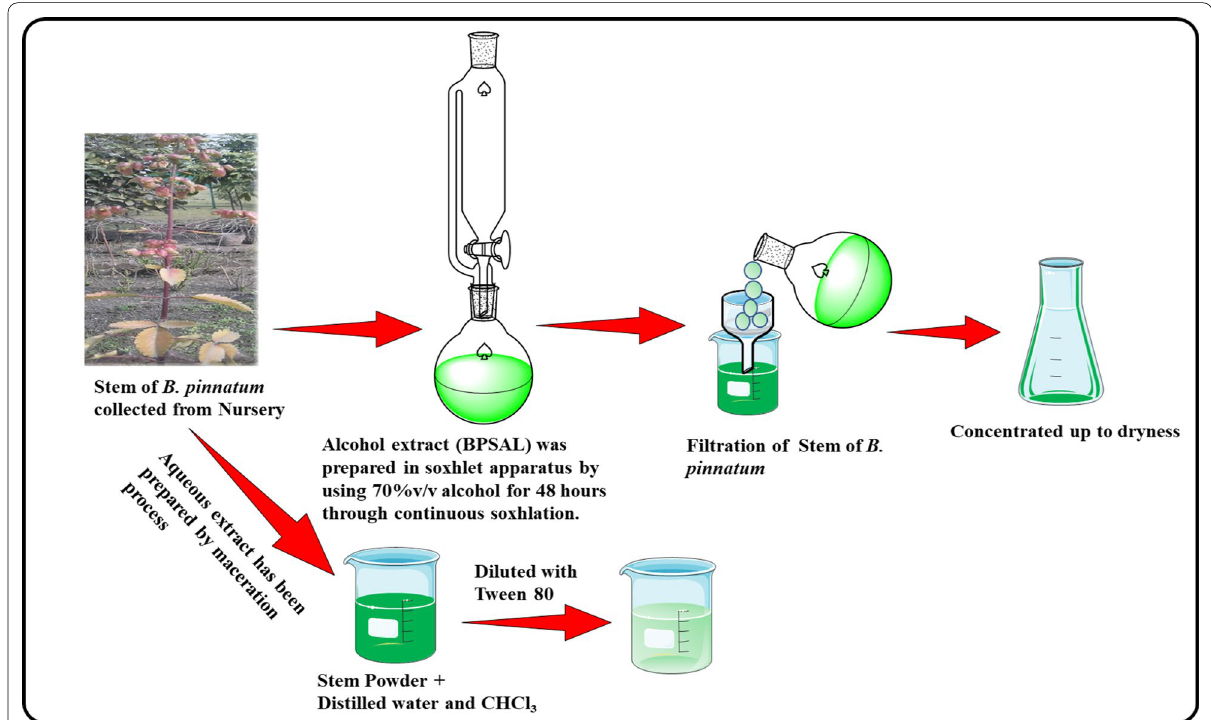
Fig. 4 Preparation of BPSAQ and BPSAL